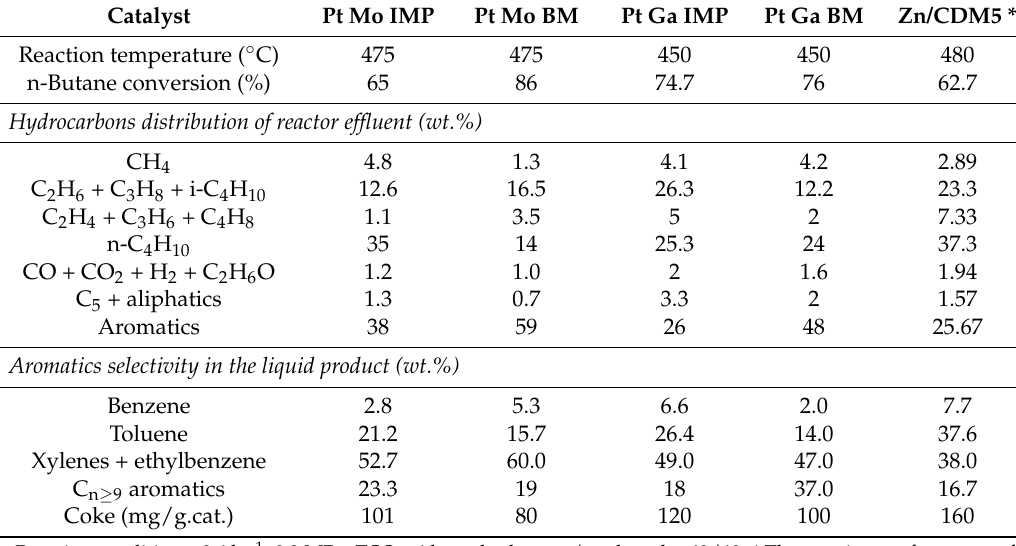
Table 3. The Pt Mo/Ga and Zn/CDM5 catalysts performance in the aromatization of cofeeding n-butane with methanol at the optimized reaction